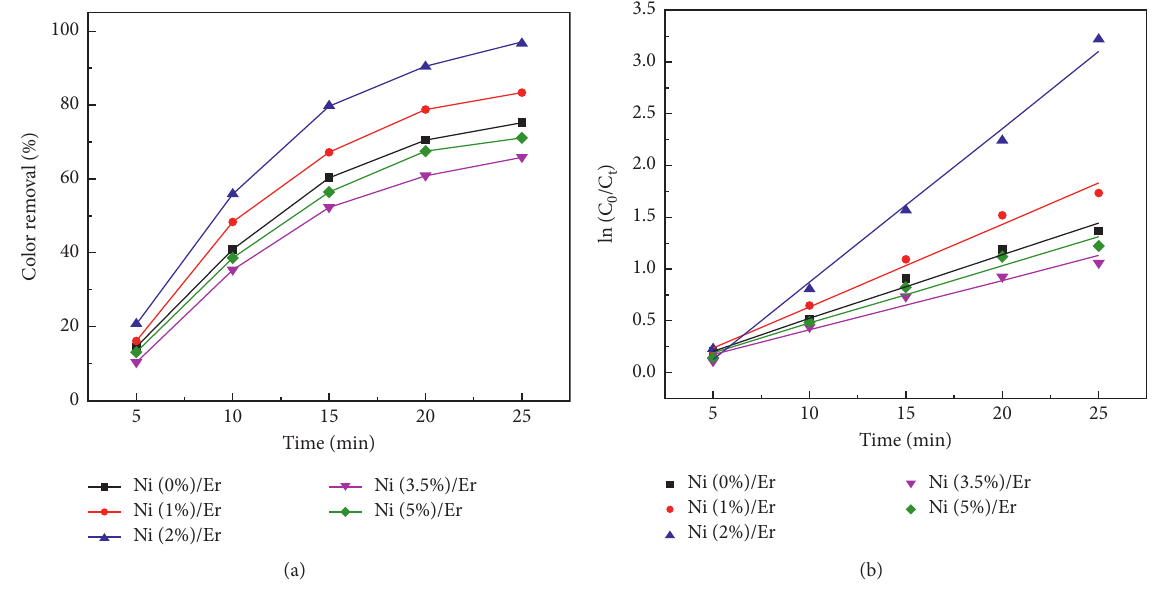
Figure 13: Electrochemical decolorization performance at Ti/SnO 2 -Sb-Ni/Er electrodes modified with various Ni contents. (a) Decol- orization efficiency. (b) Kinetic analysis of the curves (RhB concentration: 20mg · L − 1 ; current density: 10mA · cm − 2 ; supporting electrolyte: 0.1mol · L − 1 Na 2 SO 4 ; 25 ° C). Table 8: Kinetic parameters of 20mg · L − 1 RhB in electrochemical processes by Ti/SnO 2 -Sb-Ni/Er electrodes modified with various Ni